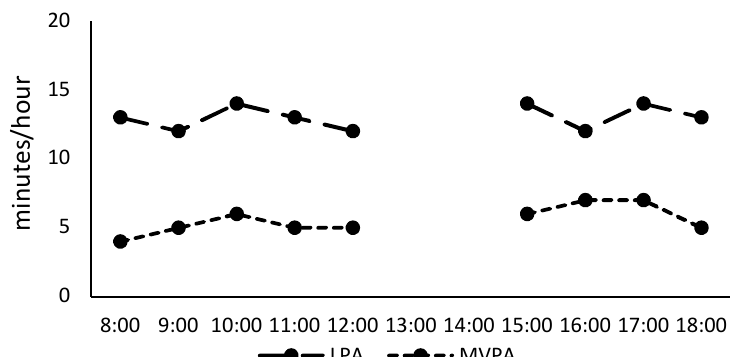
Figure 1. Means of hourly light-intensity physical activity (LPA) and moderate- and vigorous-intensity physical activity (MVPA) levels between 8:00 AM and 7:00 PM among toddlers.